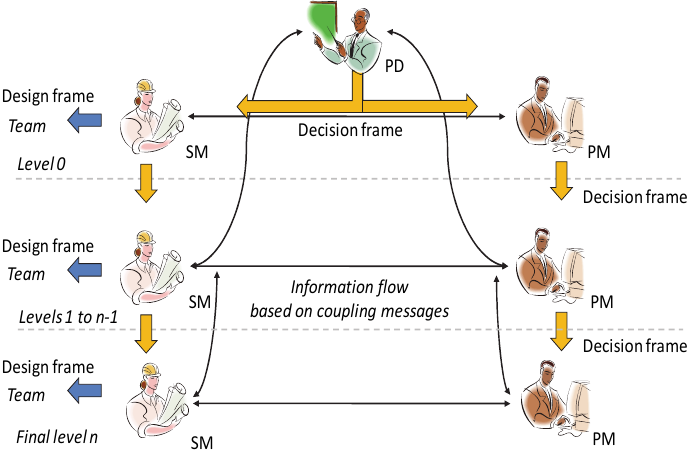
Fig. 4. ATLAS Organizational